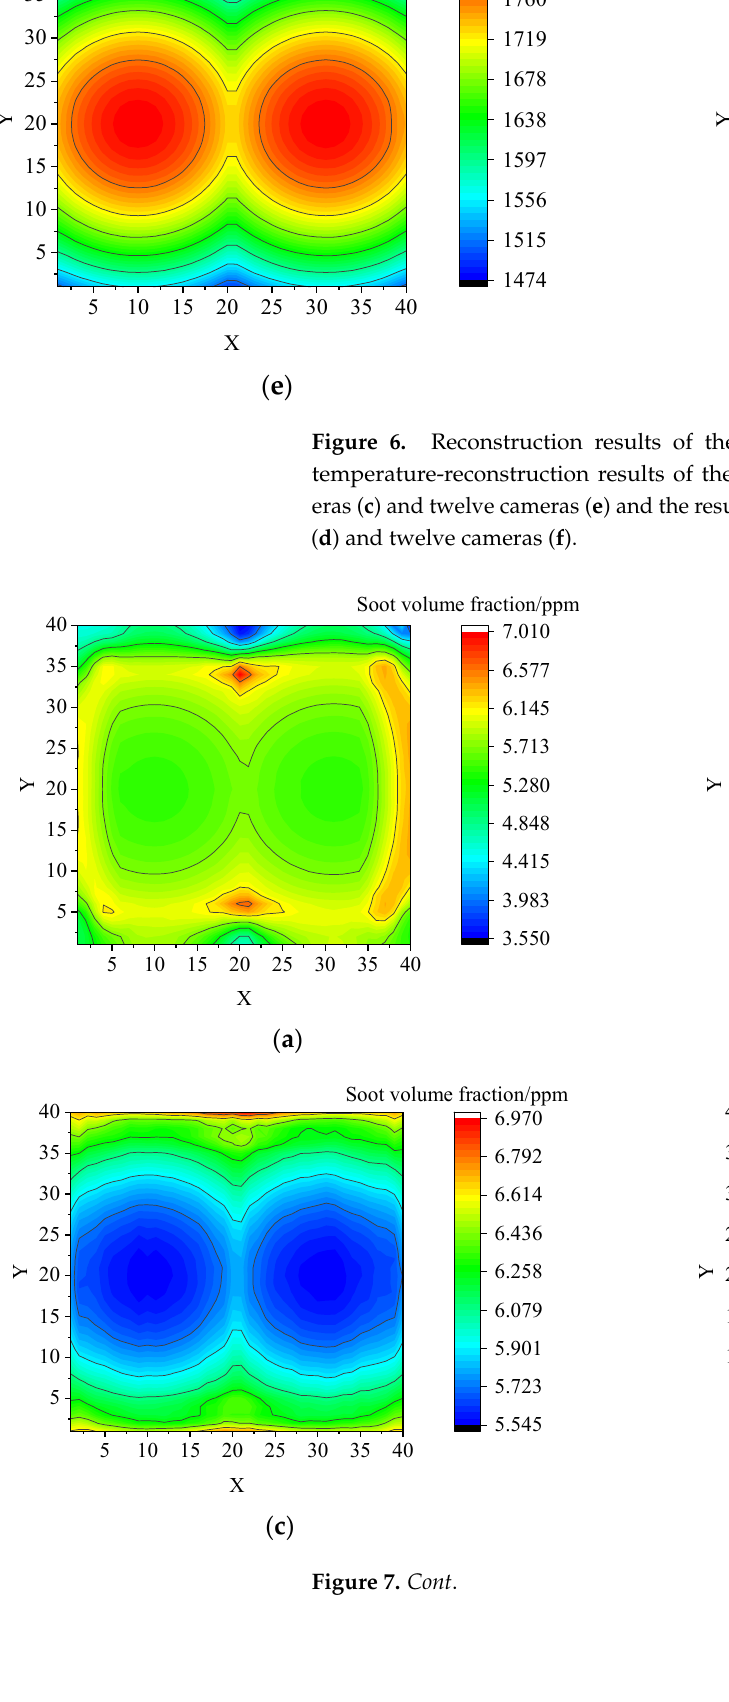
( f ) Figure 7. Reconstruction results of the two algorithms with different numbers of cameras: soot-con- centration reconstruction results of the regularization algorithm at four cameras ( a ), six cameras ( c ) and twelve cameras ( e ) and the reconstruction results of the LSQR algorithm at four cameras ( b ), six cameras ( d ) and twelve cameras ( f ). Figure 8. The RMSEs of the two algorithms for the reconstruction temperature and soot-concentra- tion variation with the number of cameras.